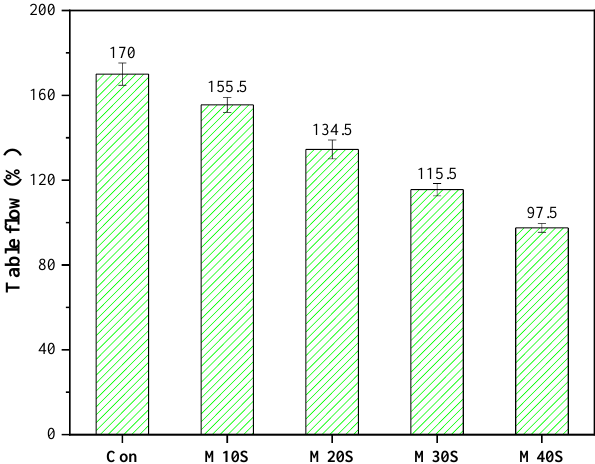
Figure 4. The table flow test results of the fresh mortars.